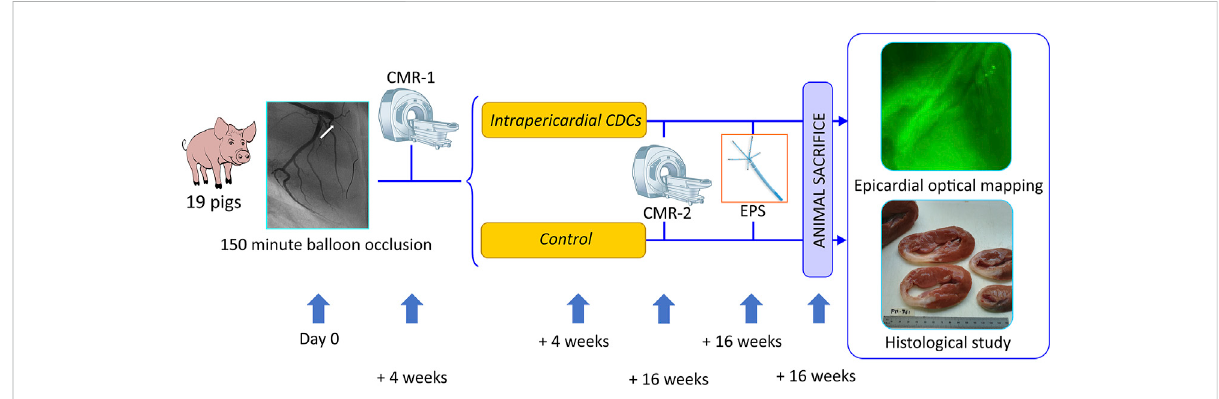
FIGURE 1 Study protocol. Nineteen Large White pigs with an induced anterior myocardial infarction were randomized to receive intrapericardial CDCs or to a sham procedure. Abbrv: CDC = cardiosphere-derived cells, CMR = cardiac magnetic resonance, EPS = electrophysiologic